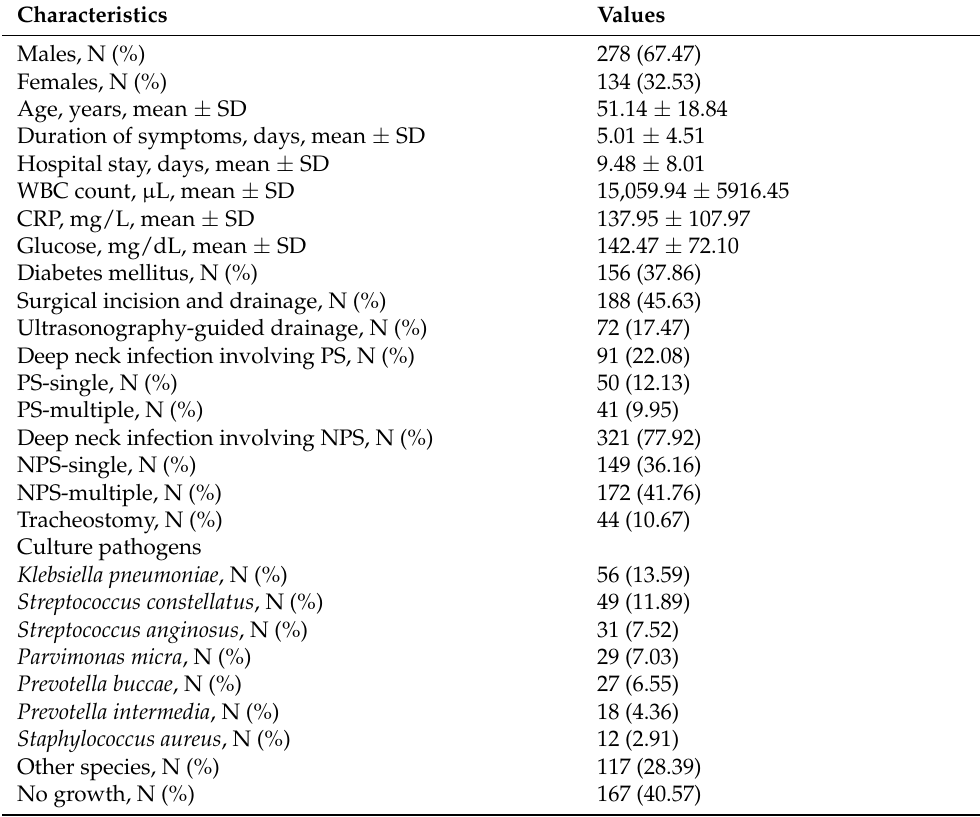
Table 1. Clinicopathological characteristics of the 412